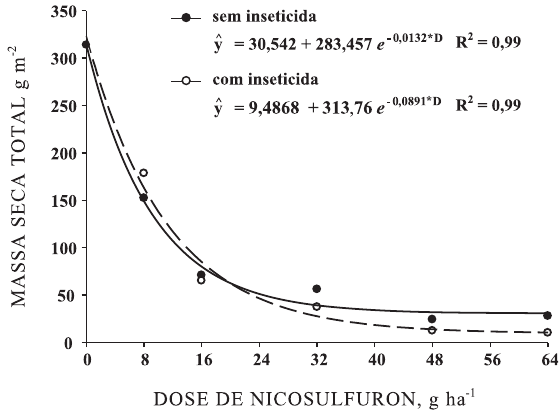
Figura 1. Massa total de plântulas secas provenientes do banco de sementes, coletadas aos 20, 40 e 60 dias após a aplicação de doses do nicosulfuron com e sem a aplicação simultânea do inseticida